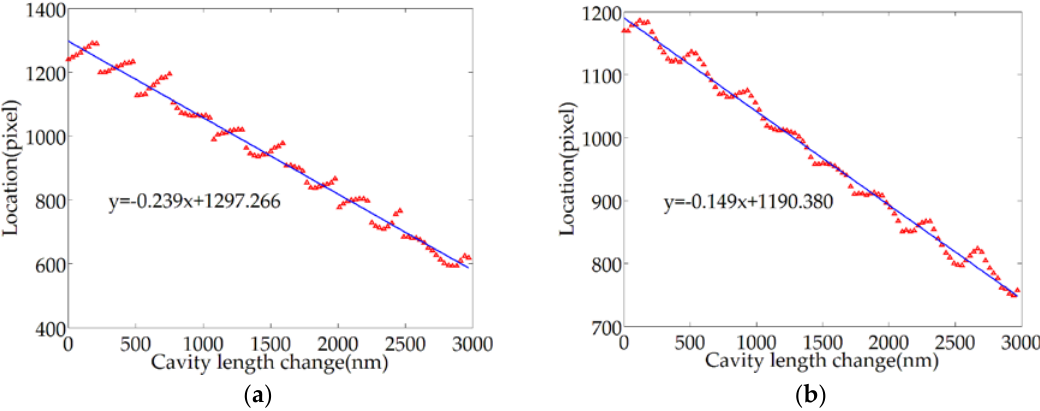
Figure 15. The curve of the envelope center: ( a ) the curve of envelope center-cavity length obtained by centroid method; ( b ) the curve of envelope center-cavity length obtained by Fourier transform.